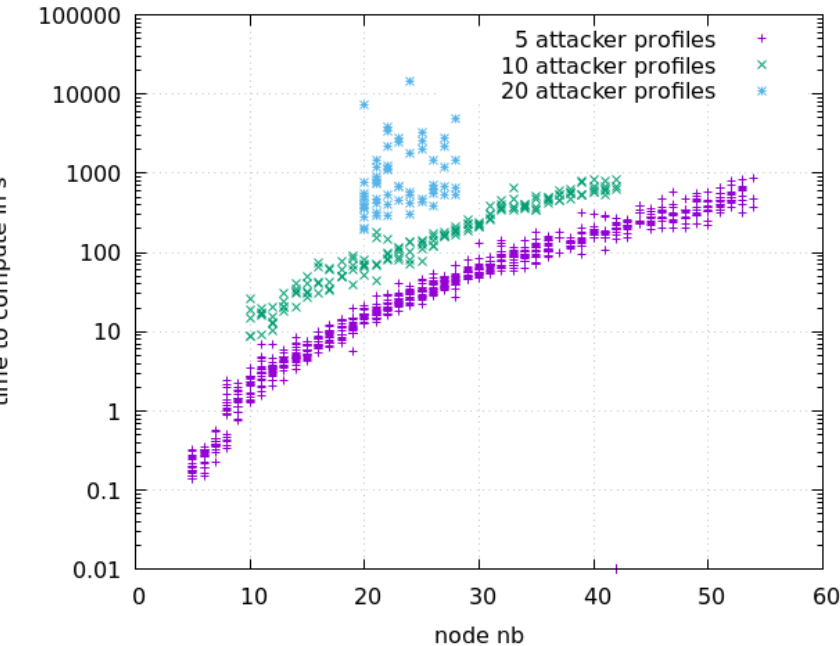
Figure 5. Randomly generated models with a fixed number of attacker profiles and a variable number of